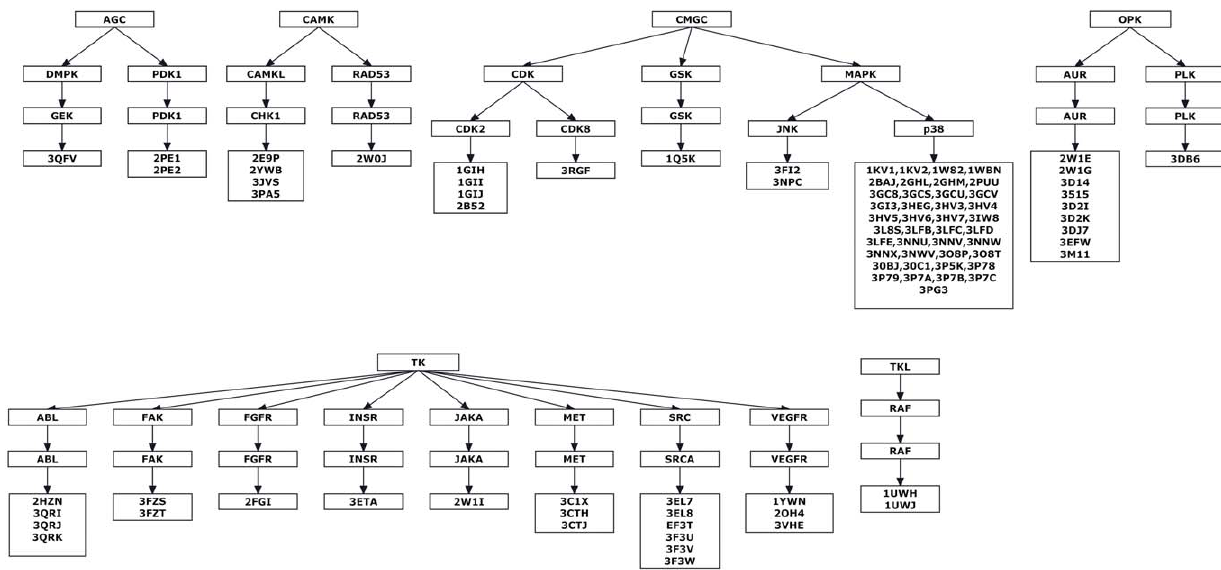
Figure 3. Classification of urea derivatives kinases complexes deposited in literature according to their families, subfamilies and groups and listing the PDB codes of each group.